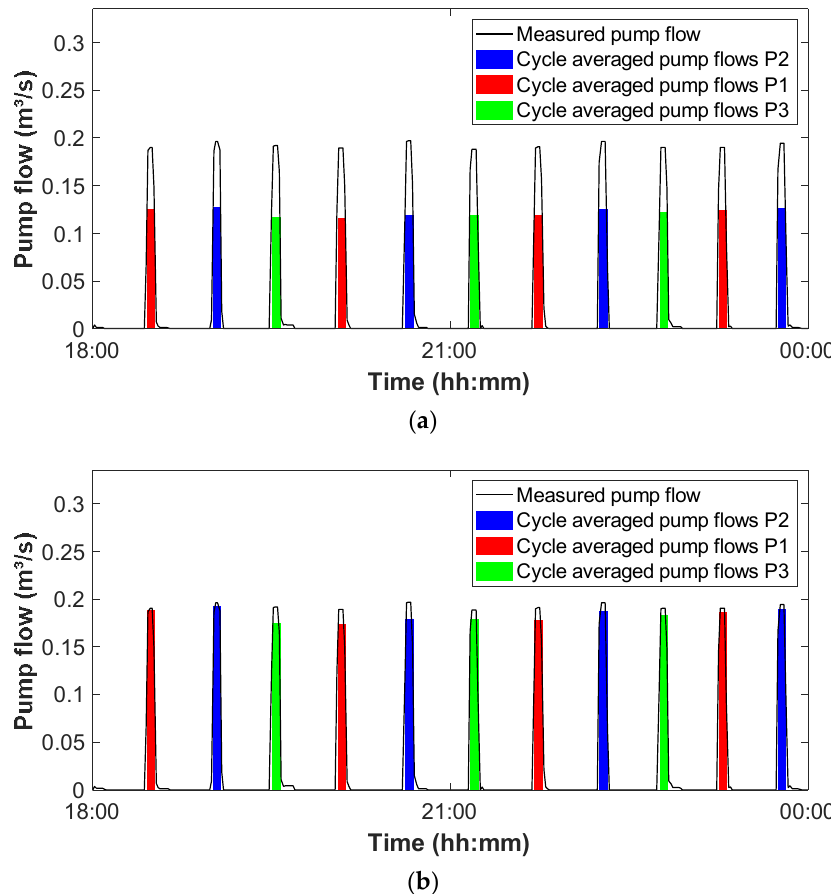
Figure 9. Calculated vs. measured pump flows before ( a ) and after ( b ) control volume correction (PS Vuntlaan).